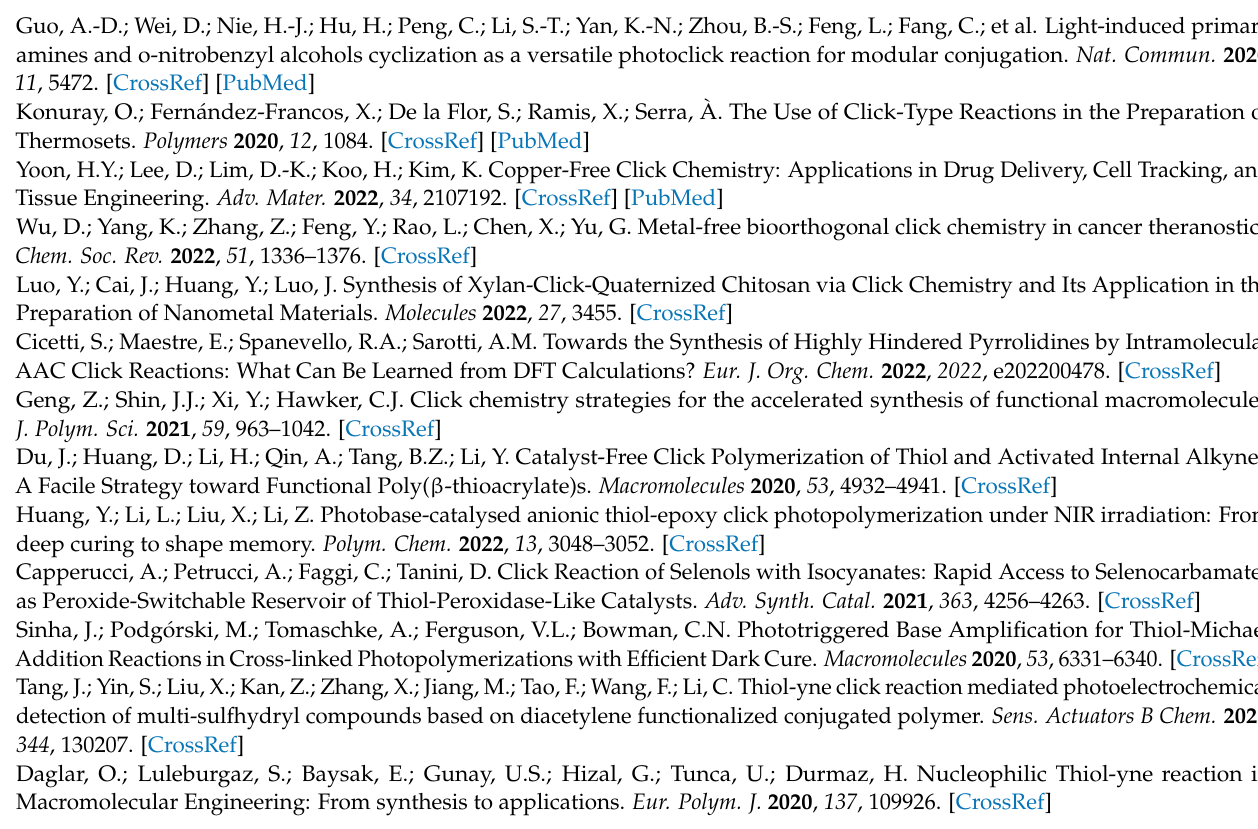
and various adsorbents published in the literature; Table S3: Comparison table for MEB adsorp- tion capacity of OTCP2 and various adsorbents published in the literature; Figure S35: Nonlinear Langmuir and Freundlich isotherm models of Li+ on OTCP2; Figure S36: Nonlinear Langmuir and Freundlich isotherm models of MEB on OTCP2; Figure S37: Nonlinear Pseudo first- and second-order models of MEB on OTCP2; Figure S38: Regeneration tests results of OTCP2 to adsorb